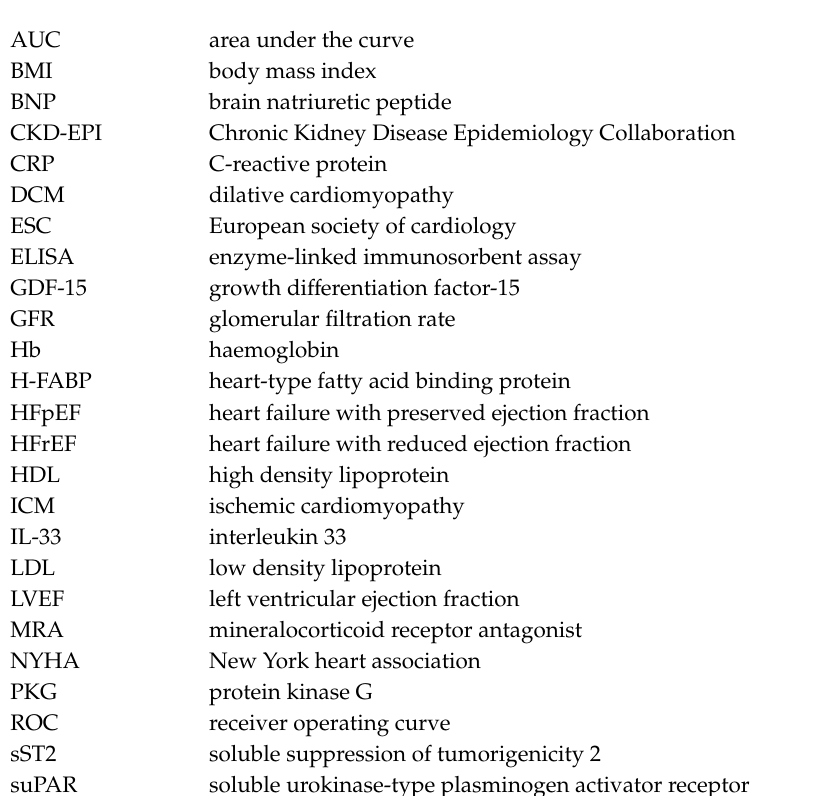
Table S1: Correlation Analysis of baseline characteristics and biomarkers; Table S2: Results after correction for multiple testing